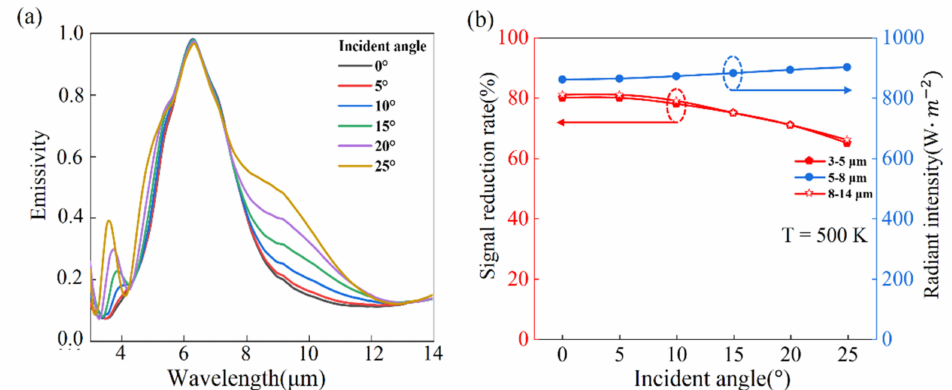
Figure 5. ( a ) Spectral emissivity of cGST thermal emitter in the incident angle changing from 0 ◦ to 25 ◦ ; ( b ) is IR signal reduction rates of our designed cGST thermal emitter in wavelength ranges of 3–5 µ m and 8–14 µ m at 500 K for various incident angles, respectively. The radiant intensity in wavelength ranges 5–8 µ m at 500 K for different incident angles.